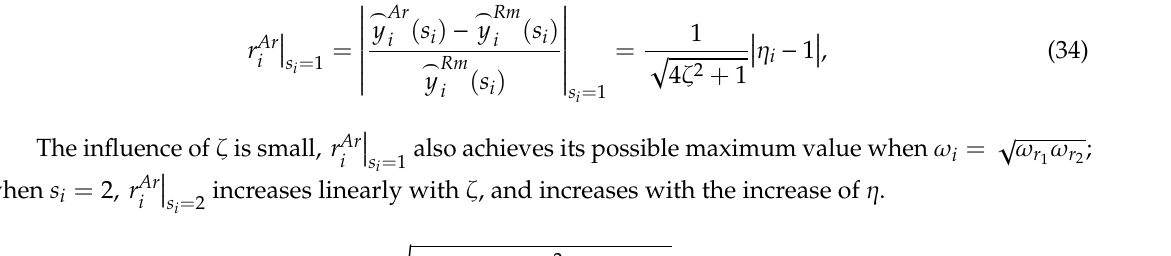
Figure 4. Examples of Am r for a particular parameter setting.